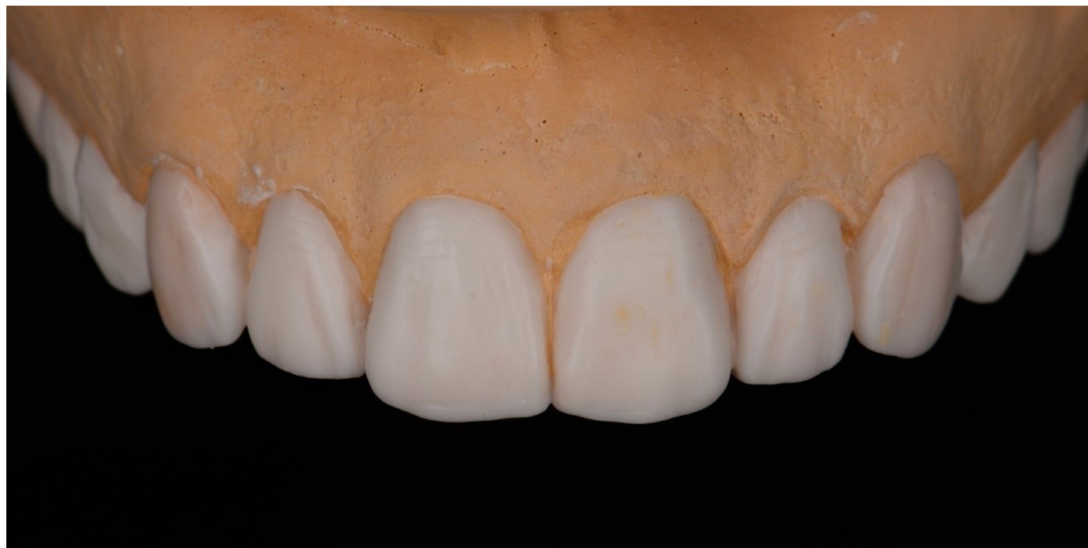
Figure 5. A diagnostic wax